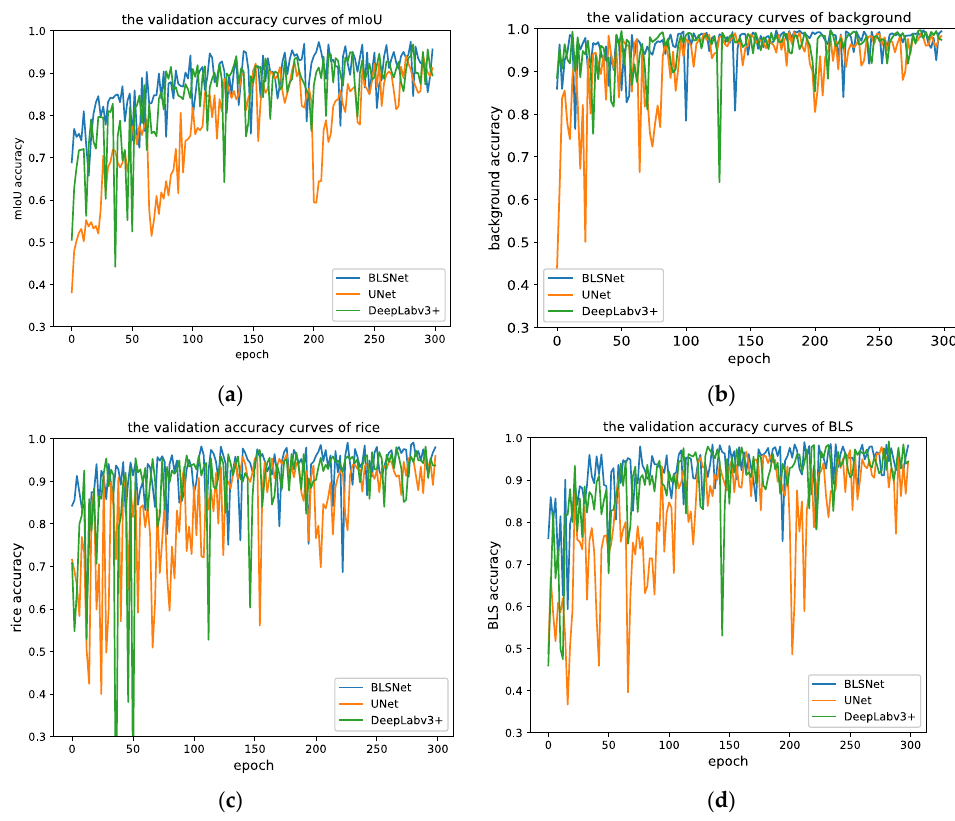
Figure 10. Validation curves of criteria for different models. ( a ) the validation curves of mIoU of three models; ( b ) the validation curves of segmentation accuracy of background of three models; ( c ) the validation curves of segmentation accuracy of rice of three models; ( d ) the validation curves of segmentation accuracy of BLS of three models.